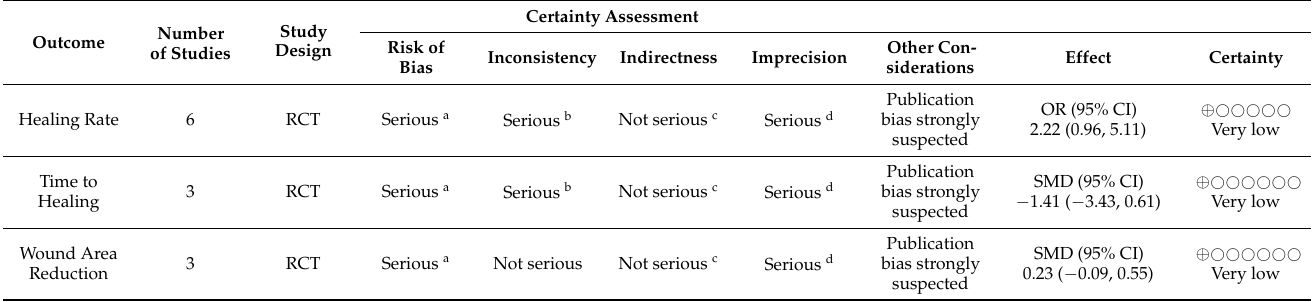
Table 1. GRADE assessment for the effect of UAW on the healing of DFU.